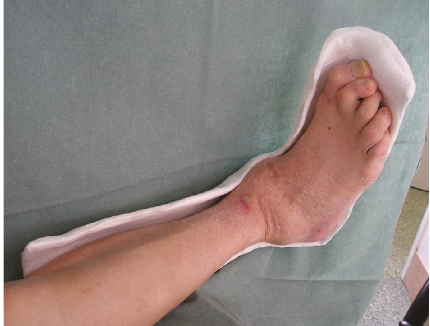
Figure 2: Dorsal L — removable contact splint — fi nal